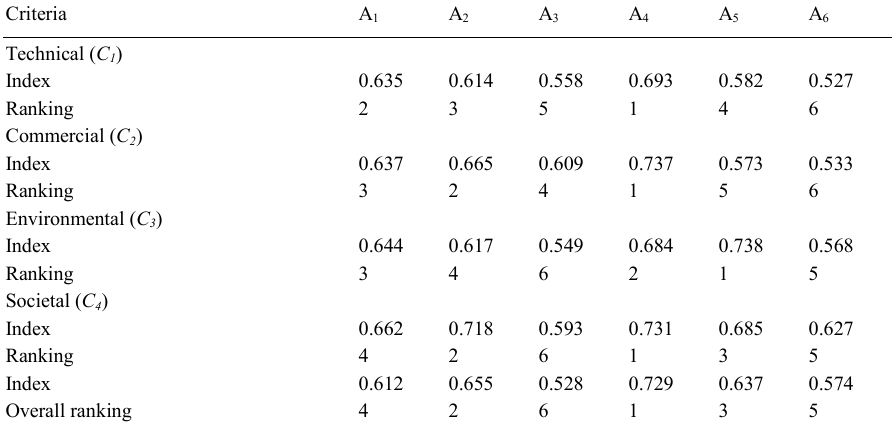
Table 10. The performance index of recoverable end-of-life product alternatives and their rankings. Criteria